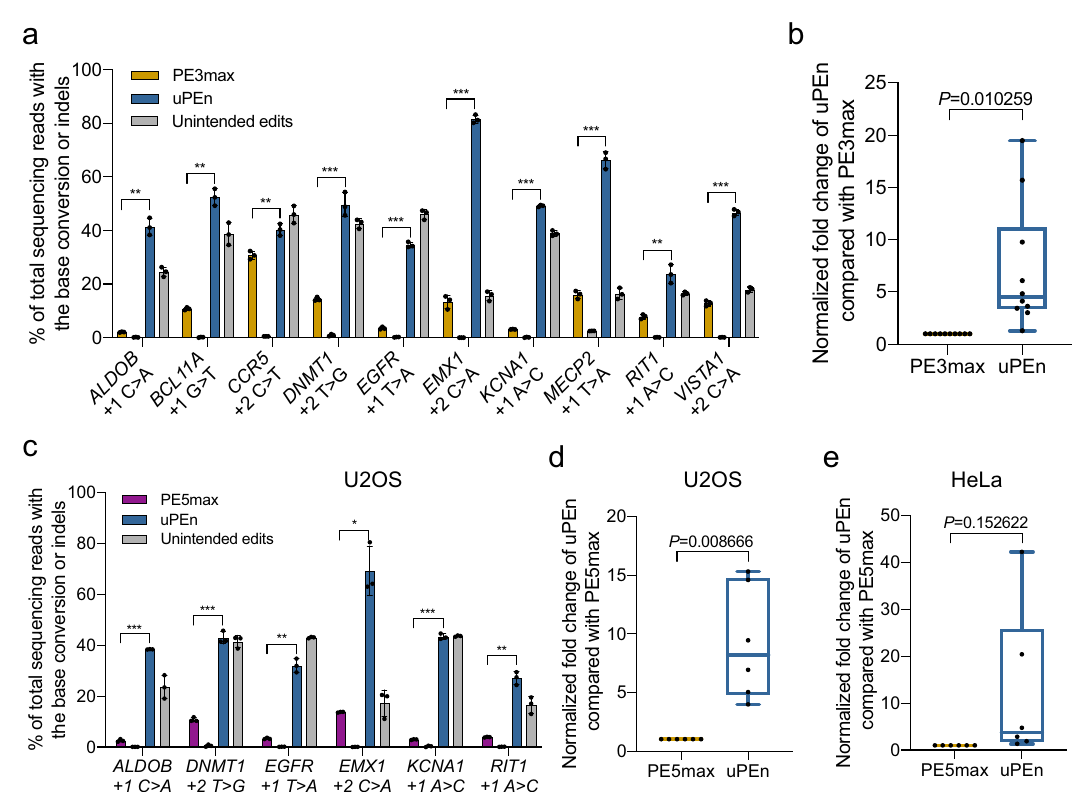
Fig. 4 | The uPEn mediated ef fi cient base conversions at some largely PE- intractablesites.a Comparisonofbaseconversionef fi cienciesandindelsinduced by PE3max and uPEn (in the uPEn3 format, same throughout this fi gure) at ten endogenous sites in HEK293T cells.Values and error barsre fl ect the meanand s.d. of three biological replicates. P values were determined (for precise editing ef fi - ciencies between PE3max and uPEn at individual sites) by two-tailed Student ’ s t-tests. The asterisks on the graph are used to indicate the ranges (** P <0.005, *** P <0.0005).Therespective P valuesinaccordancetotheirleft-to-rightorderare: 0.002209, 0.001554, 0.003482, 0.000163, 0.000001, 0.000002, 0.000001, 0.000015, 0.001491, 0.000003. b Summary of the fold change in uPEn ef fi ciency normalized to PE3max at the same target sites in ( a ). The mean editing frequency inducedbyPE3maxforeachlocuswassetto1,andothersampleswerenormalized correspondingly. The center line shows medians of all data points and the box limitscorrespondtotheupperthelowerquartiles,whilethewhiskersextendtothe largest and smallest values. n =10 (sites) for each group. The P value (directly marked on the graph) was determined by a two-tailed one-sample Student ’ s t -test.